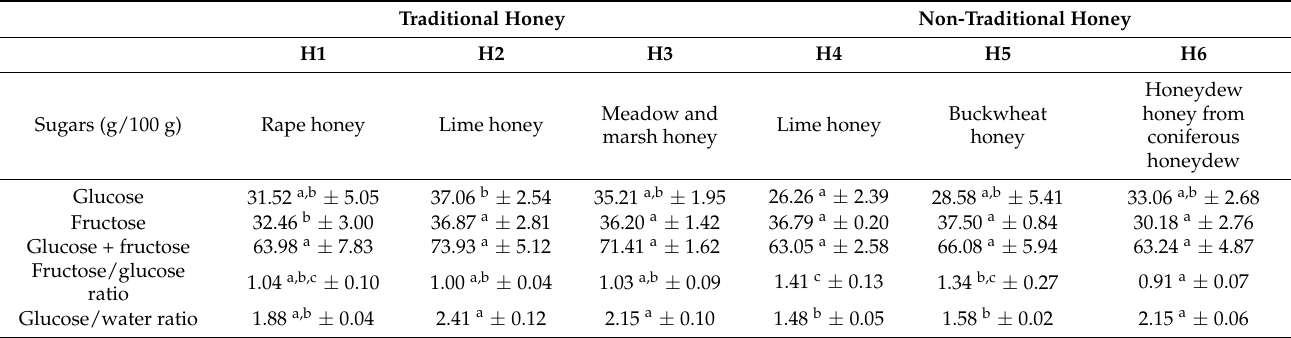
Table 2. Percentage of reducing sugar in